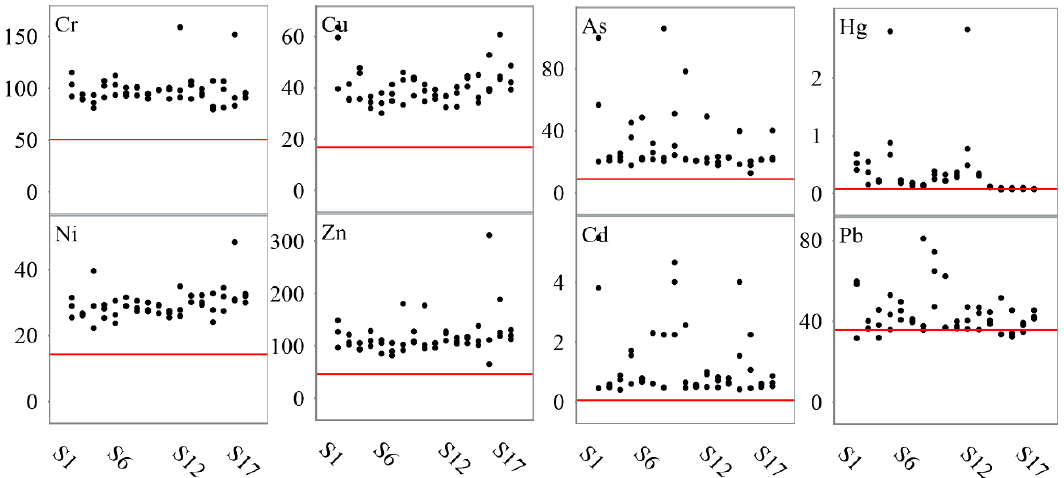
Figure 2. Concentration of the investigated soil-borne trace elements (Cr, Cu, As, Hg, Ni, Zn, Cd and Pb) compared to their respective background values.